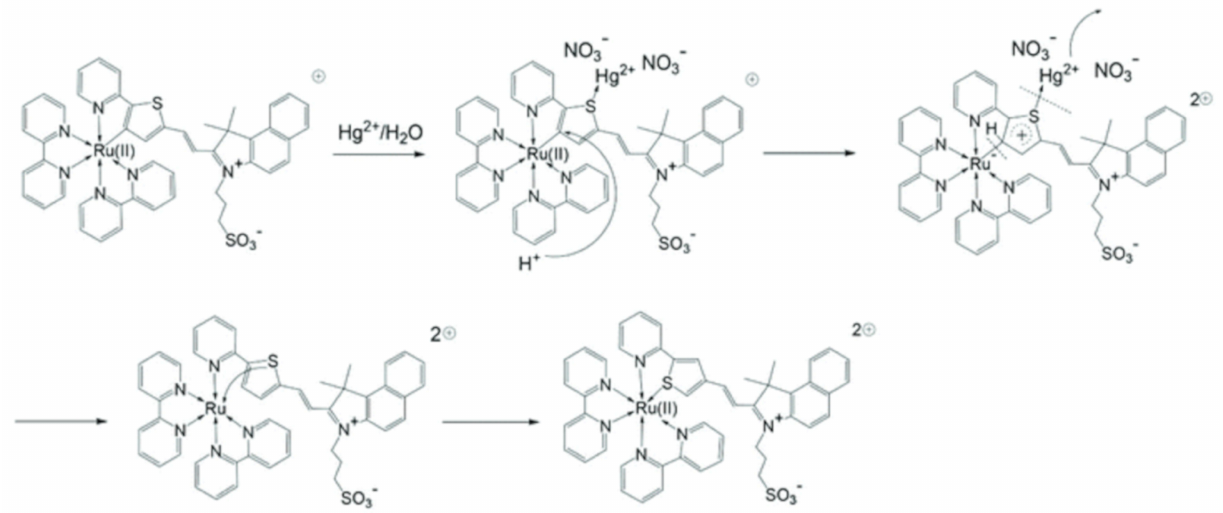
Figure 29. The possible sensing mechanism of 85 with Hg 2+ . Reproduced with permission from [110]. Copyright 2020 The Royal Society of